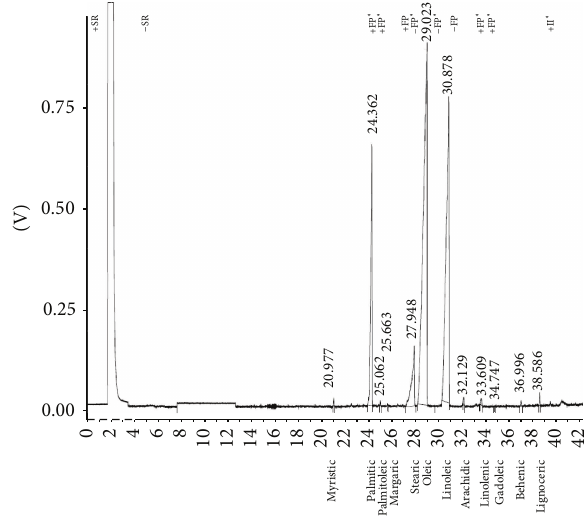
Figure 1: Chromatogram of FAME of a sample of argan oil.